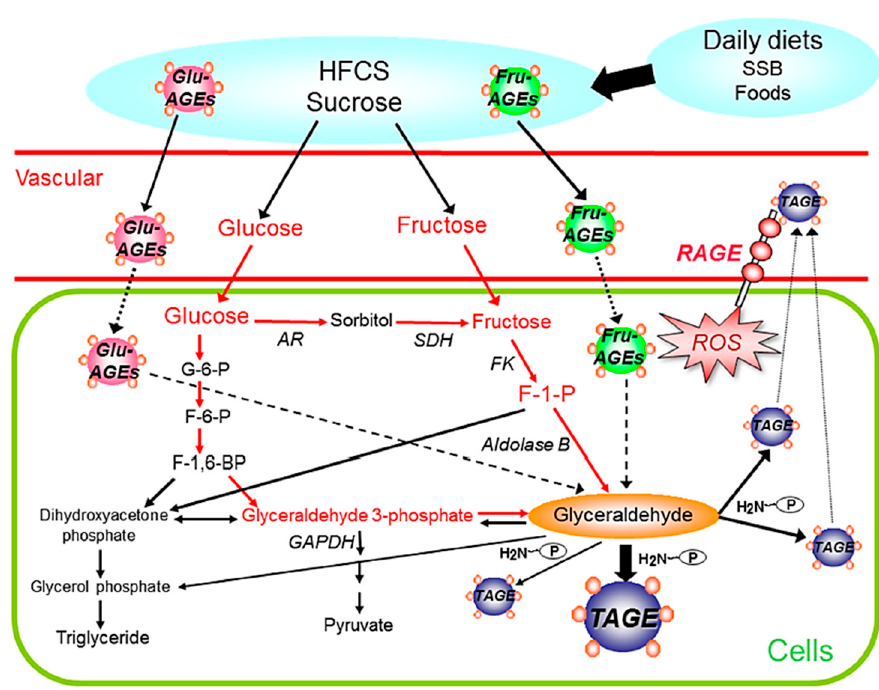
Figure 2. Routes for in vivo TAGE generation: The chronic ingestion of excessive amounts of sugar-sweetened beverages (SSB) and commercial food products increases the levels of the sugar metabolite, glyceraldehyde in cells. The glyceraldehyde produced induces the generation of TAGE in intracellular compartments. As a result, TAGE accumulate in cells, cause cell damage, and leak into the blood, and, thus, TAGE levels in circulating fluids may be considered to increase. Furthermore, the chronic ingestion of excessive dietary AGEs (mainly Glu-/Fru-AGEs) increases the enhanced generation/accumulation of TAGE and the expression of RAGE, thereby leading to TAGE-RAGE interactions. Interactions between TAGE and RAGE alter intracellular signaling, gene expression, and the release of pro-inflammatory molecules and also elicit the generation of ROS in numerous types of cells, all of which may contribute to the pathological changes observed in lifestyle-related diseases.